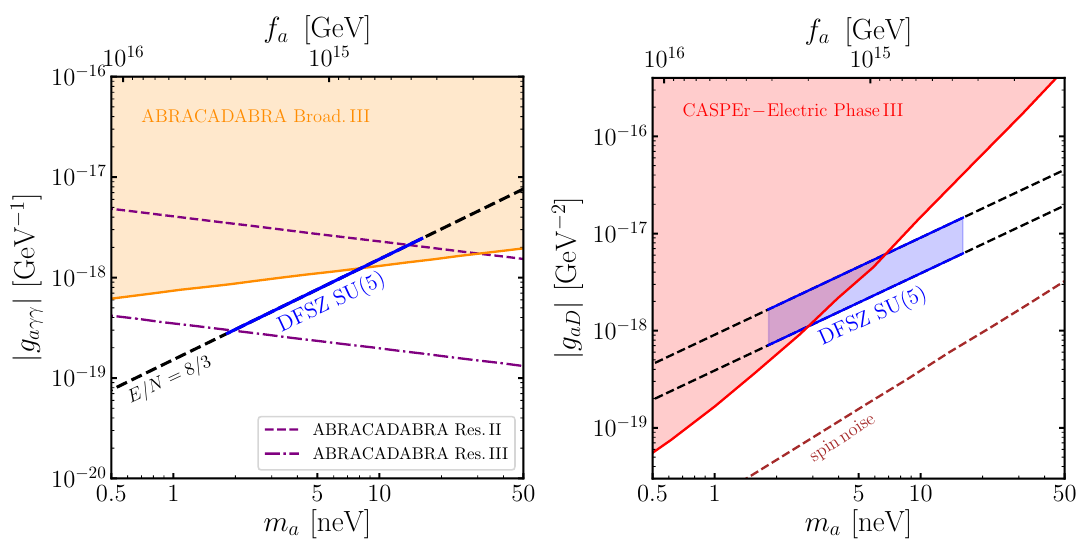
Figure 3 . Left panel : the axion coupling to photons as a function of the axion mass. The blue solid line corresponds to the prediction in the theory considered in this paper. The region shaded in orange gives the projected sensitivite for Phase III of the ABRACADABRA [25] experiment using the broadband approach. The purple dashed (dotted-dashed) line corresponds to Phase II (III) of the resonant approach. Right panel : the axion coupling to the neutron EDM as a function of the axion mass. The blue band corresponds to the theoretical error on the g aD ocupling [38]. The region shaded in red gives the projected sensitivity to Phase III of the CASPEr-Electric [39]